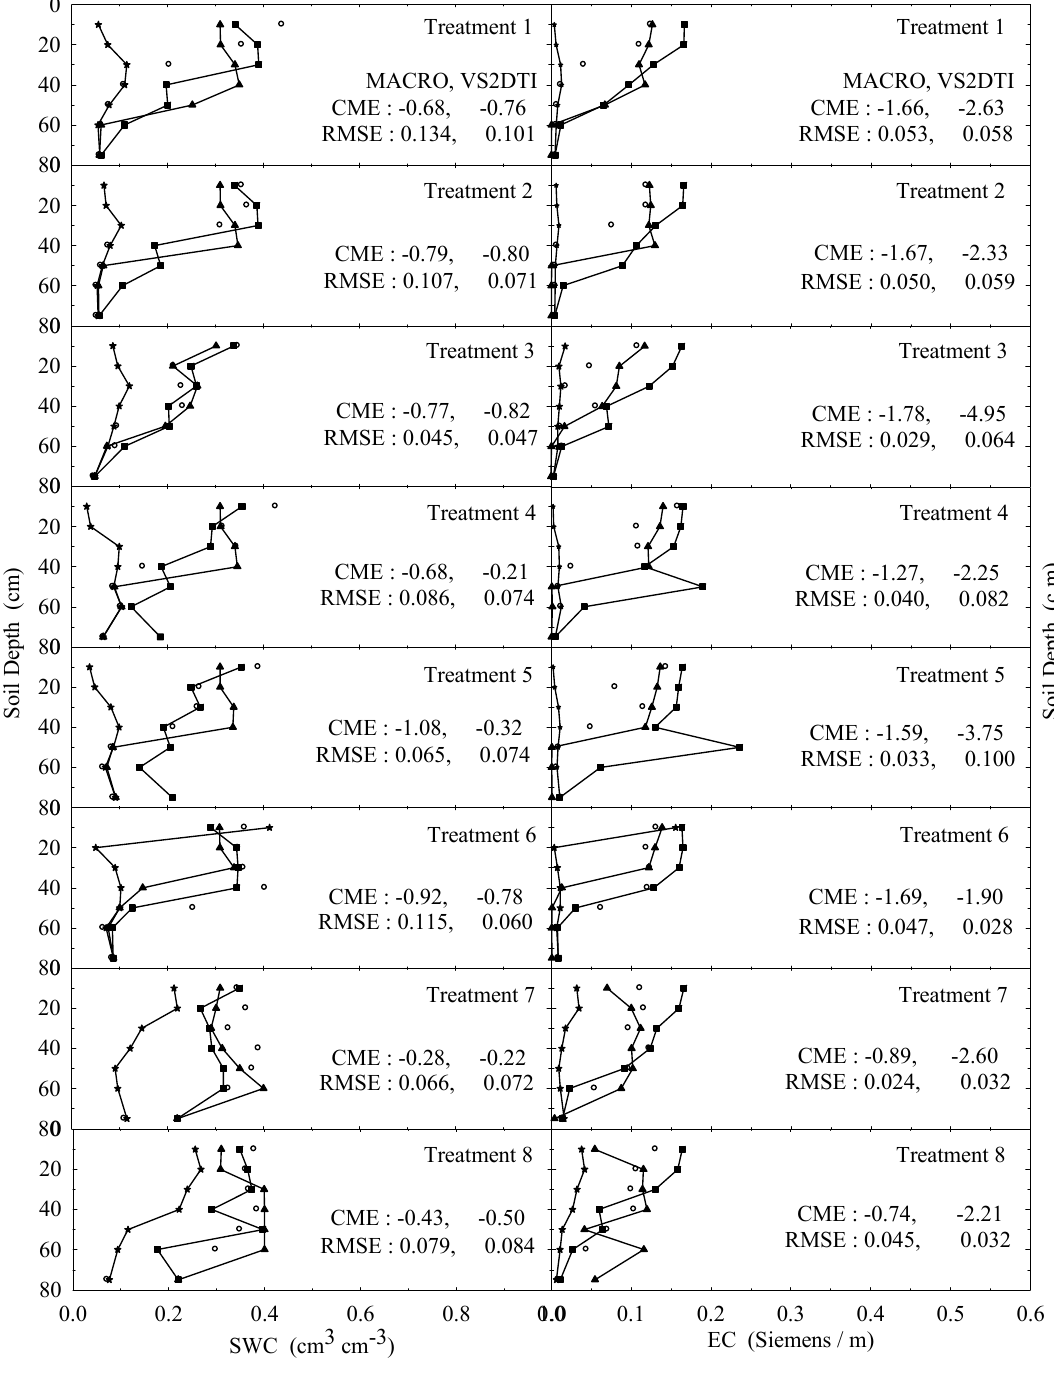
Figure 6. The variation of soil water content (SWC) and electrical conductivity (EC) with depth at 10 h of the experiment in the 8 treatments. The initial, measured, and model (MACRO and VS2DTI) values are exhibited by symbols ★ , ○ , ▲ , and ■ , respectively. CME and RMSE are the coeficient of model efficiency and the root mean square error,